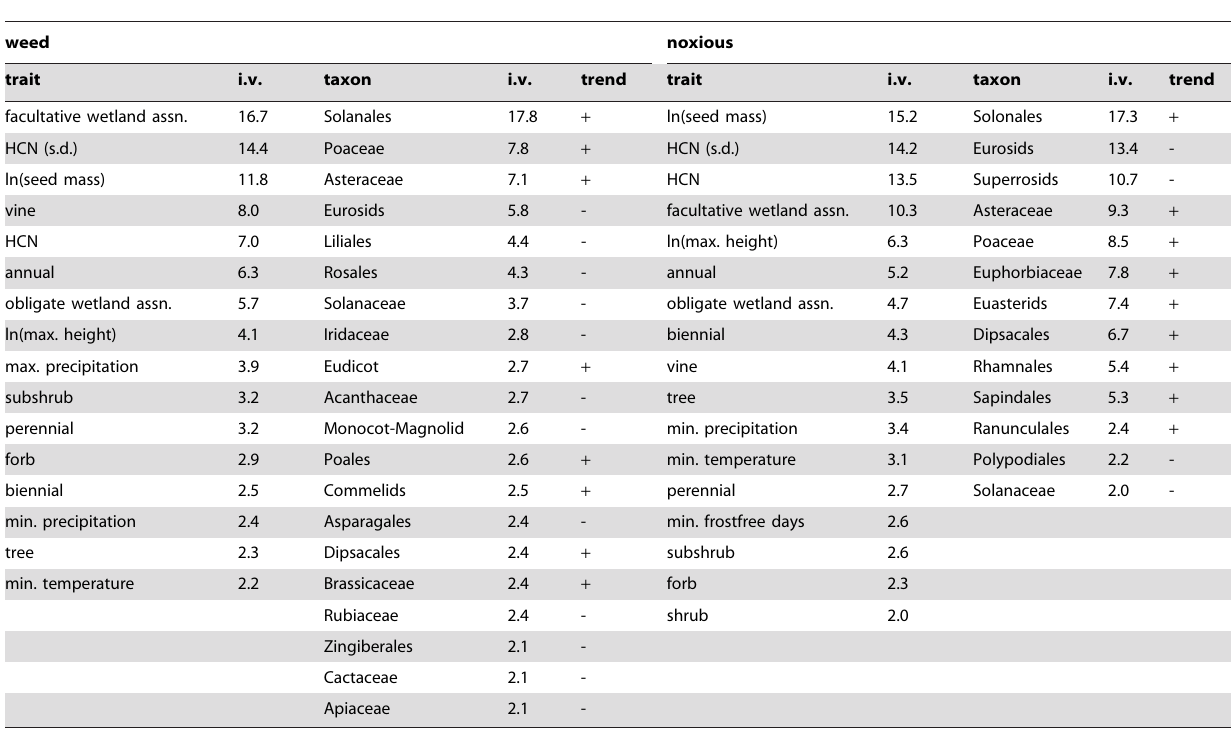
Table 2. Importance value (i.v.) of covariates calculated as the number of times each variable was selected for splitting, weighted by the squared improvement to the model as a result of each split, averaged over all trees, and rescaled to sum to 100 for proportion of weeds and noxious species.